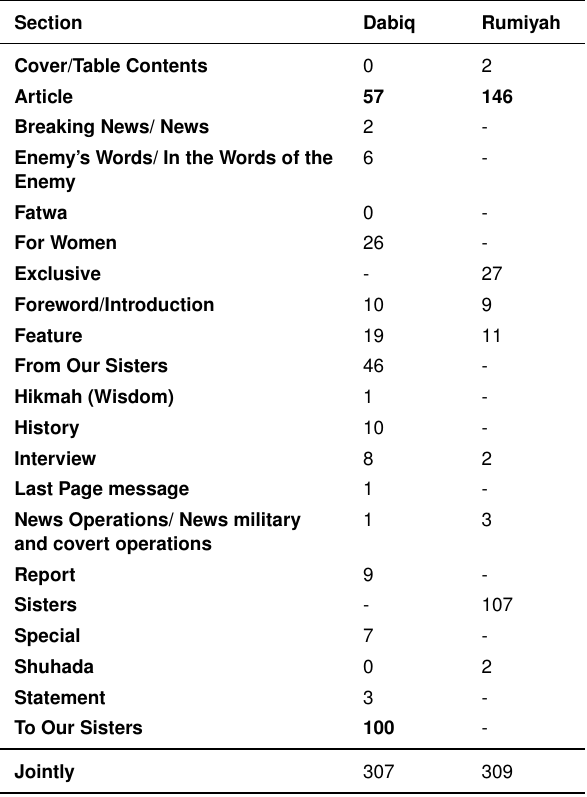
Table 5. The number of keywords and sections used in the Rumiyah magazine.